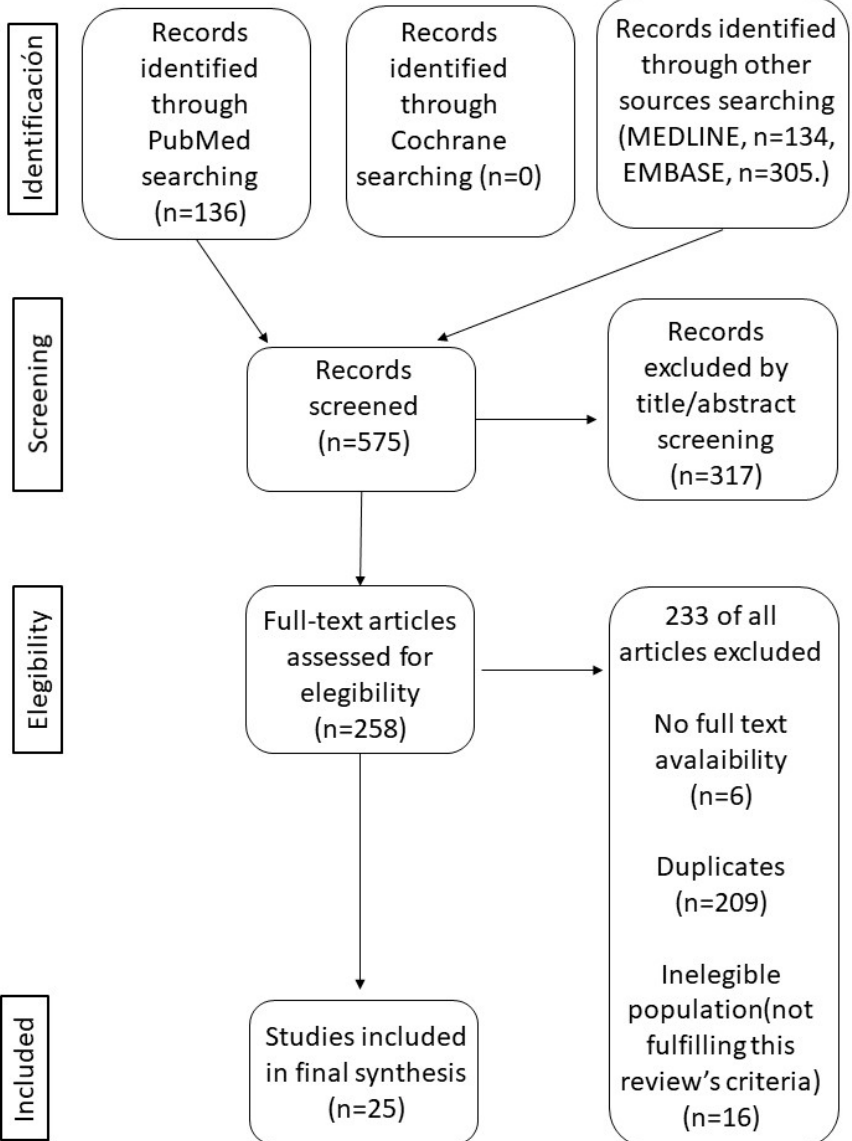
Figure 1. PRISMA flow diagram for database search and study selection process. Based on Moher et al. [19].